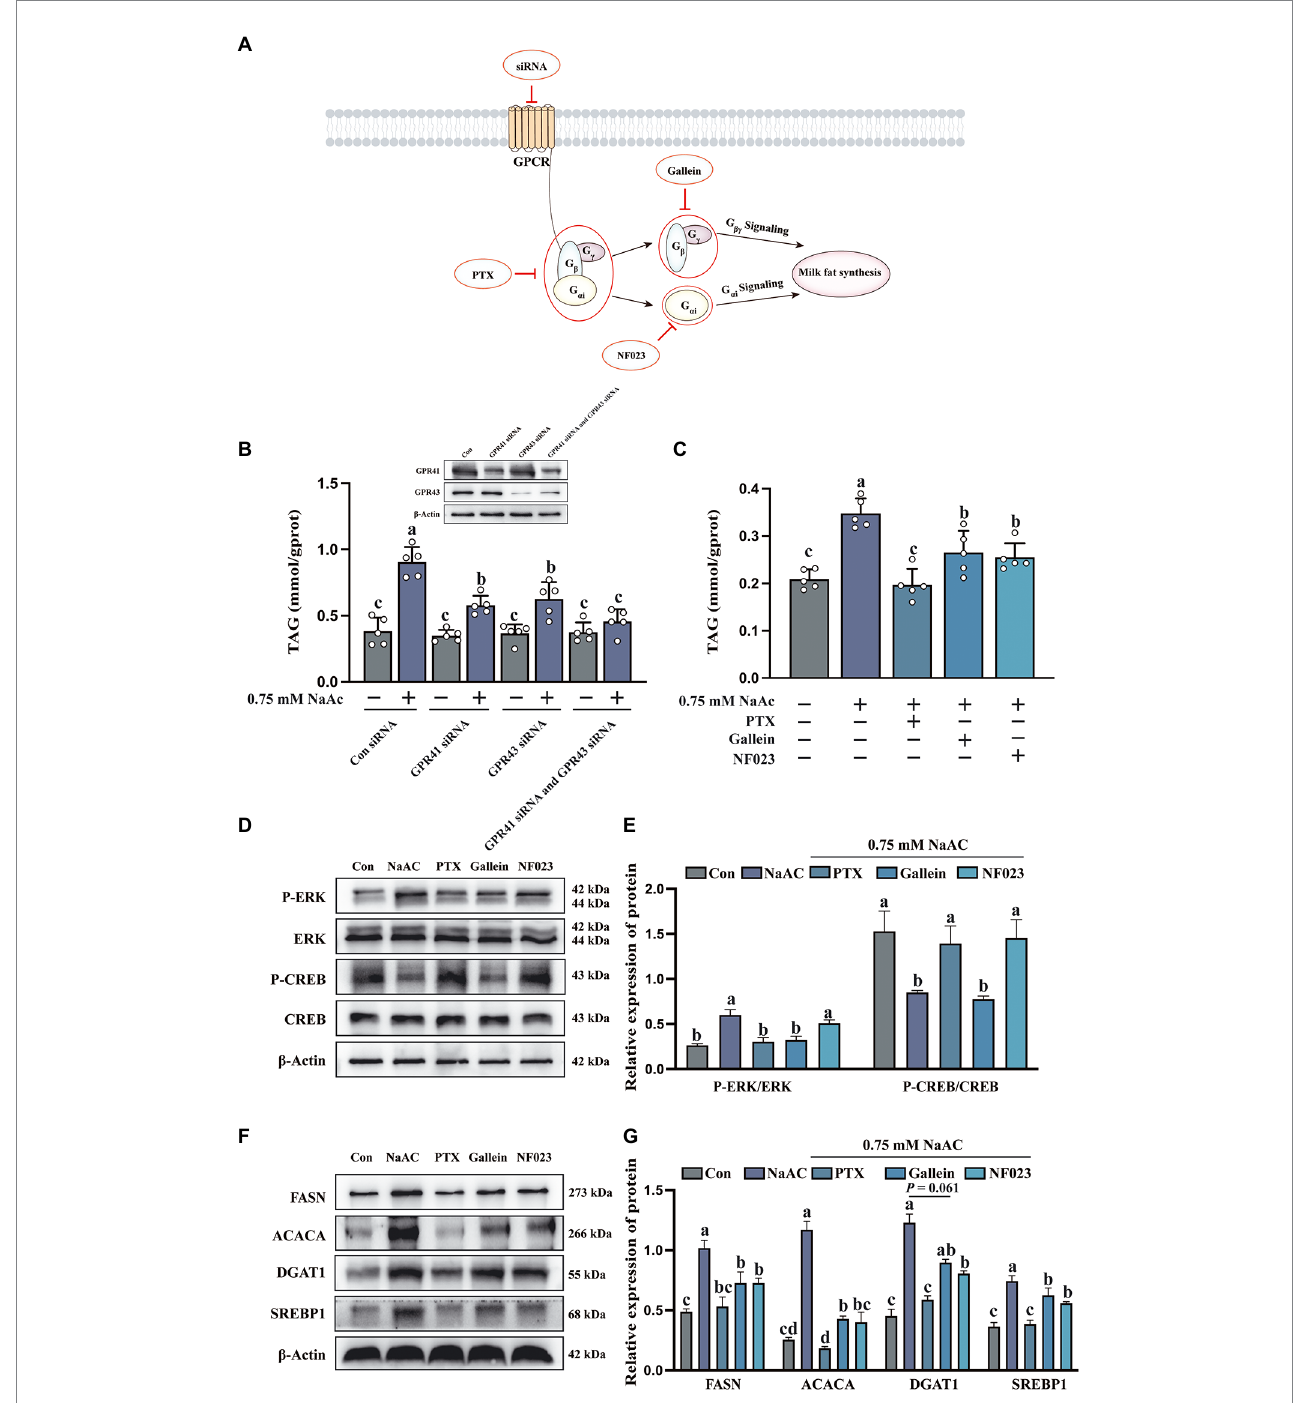
FIGURE 4 The inhibition of G protein attenuated the promoting effect of sodium acetate (NaAc) on milk fat synthesis. Cells used in this figure were pre-treated with PTX, Gallein, and NF023 for 2 h or GPR41 siRNA and GPR43 siRNA for 6 h, respectively, and then incubated with 0.75 mM NaAc for 24 h. (A) Targets of G protein-related inhibitors and siRNA. (B,C) TAG content in HC11 cells with different treatments, n = 5. (D,E) Phosphorylation degree of ERK and CREB in different treatments, n = 3. (F,G) Relative expression abundance of proteins related to milk fat synthesis, n = 3. All data with error bars are averages ± SEM. In histograms, no letter or the same letter above the bar graph indicates no significant difference ( p > 0.05), and different letters indicate a significant difference ( p < 0.05). Each small white dot represents a test